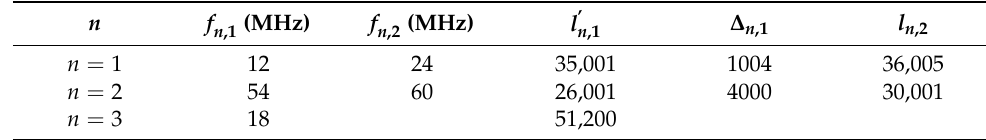
Table 6. Parameters of multiple FH signals with frequency-switching time.